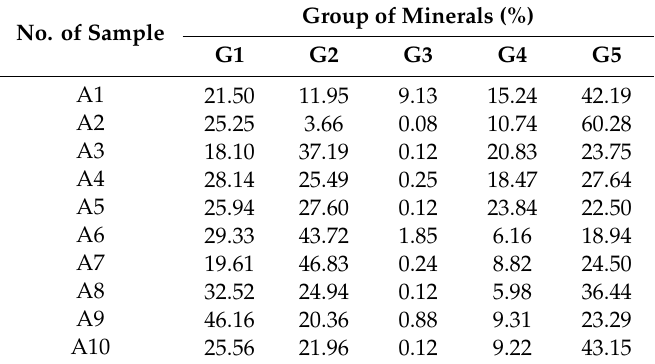
Table 4. Results of mineralogical analysis of shale samples (A1 ÷ A10) using the XRD